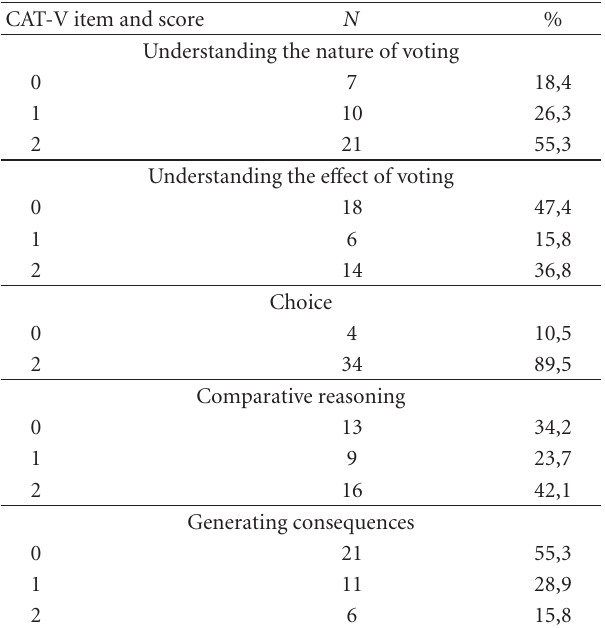
Table 2: Subjects’ score distribution on each item of the Compe- tence Assessment Tool for Voting